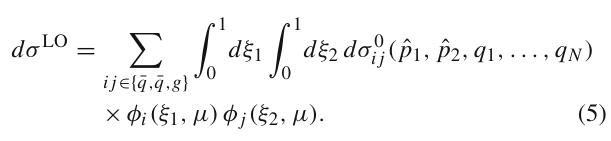
the Euler–Mascheroni constant. The formula, whose ingredi- ents will be discussed below, involves a Fourier convolution over the transverse separation x ⊥ and holds up to terms sup- / Q 2 . The cross section d σ is inclu- pressed by powers of q 2 T sive in the hadronic radiation but completely differential in the electroweak momenta q 1 , . . . , q N . To compute a specific cross section, such as the transverse momentum spectrum, one imposes suitable constraints on these momenta and inte- grates (4) over the electroweak phase